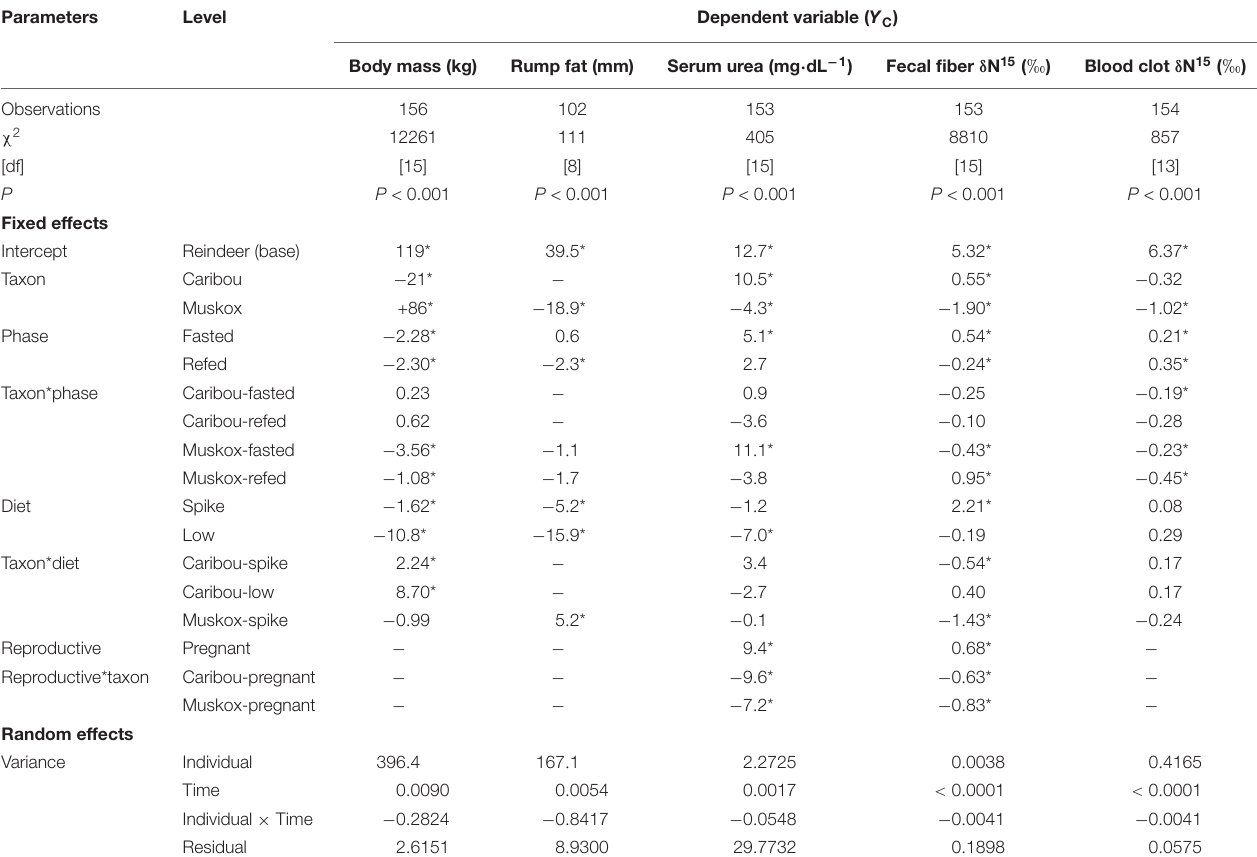
TABLE 2 | Results of mixed model regression for evaluation of body condition variables ( Y C ) in female reindeer, caribou, and muskoxen from February to April 2009 in Fairbanks, AK, United States.